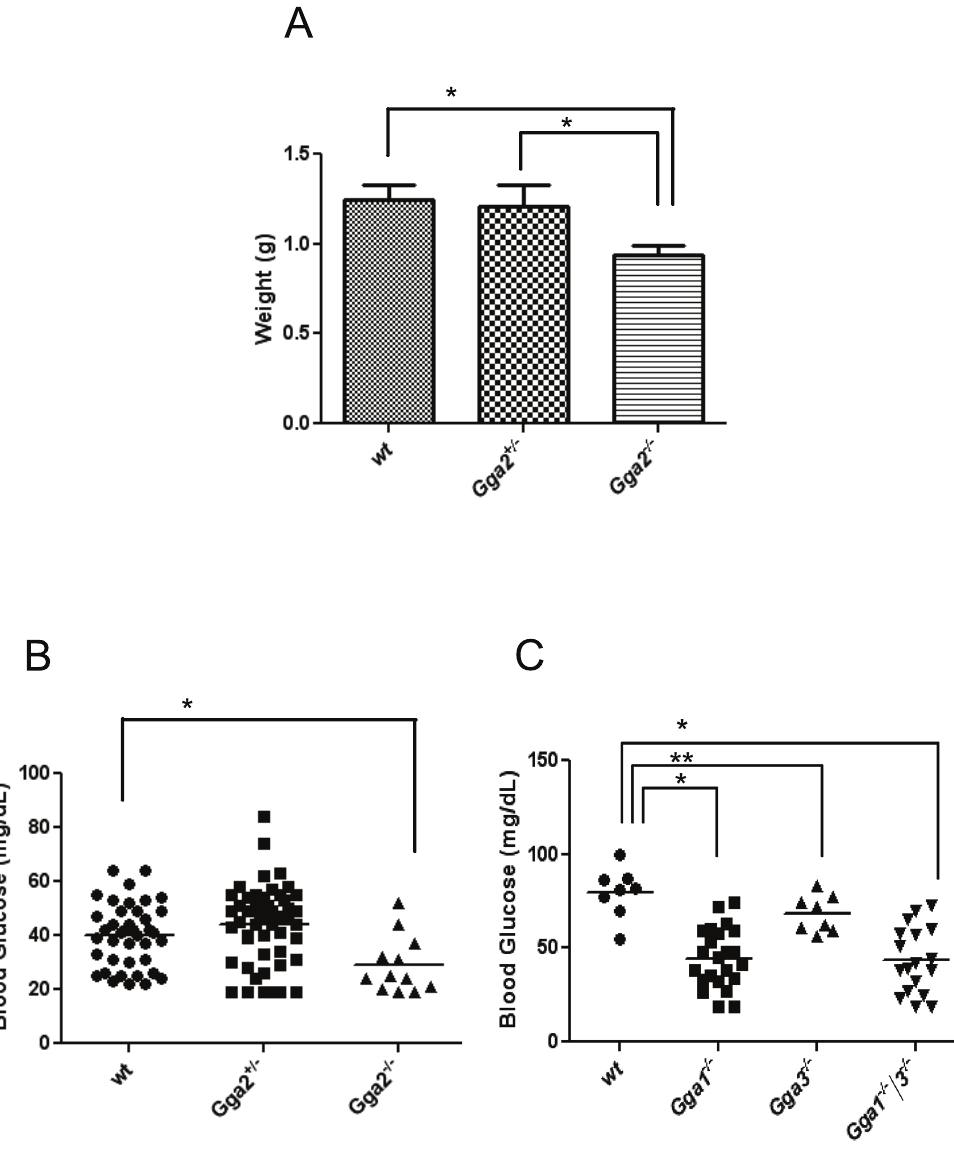
Figure 4. Gga2 null mice exhibit low birthweights and hypoglycemia. A) Birthweights were obtained on day 1 and plotted according to genotype (wt, n=42; Gga2 + / 2 , n=54, Gga2 2 / 2 , n=12). * represents p , 0.001; as determined by Student’s t-test. B) Blood glucose levels in TIGM Gga2 newborn mice were determined on day 1 and plotted according to genotype (wt, n=42; Gga2 + / 2 , n=54, Gga2 2 / 2 , n=12) * represents p , 0.001; as determined by Student’s t-test. C) Blood glucose levels in Gga1 and Gga3 newborn mice were determined on day 1 and plotted according to genotype (wt, n=10; Gga1 2 / 2 , n=23; Gga3 2 / 2 , n=20; Gga1 2 / 2 / 3 2 / 2 , n=20). * represents p , 0.001, ** represents p , 0.05; as determined by Student’s t-test.